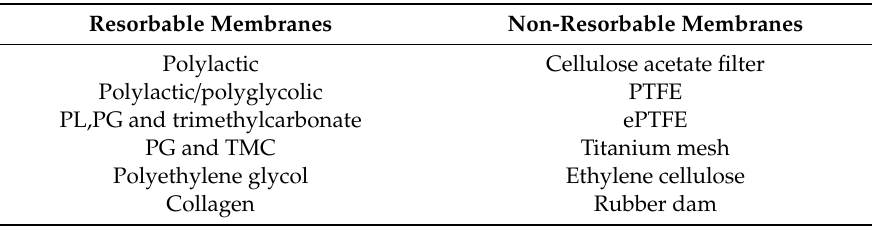
Table 2. Types of membranes